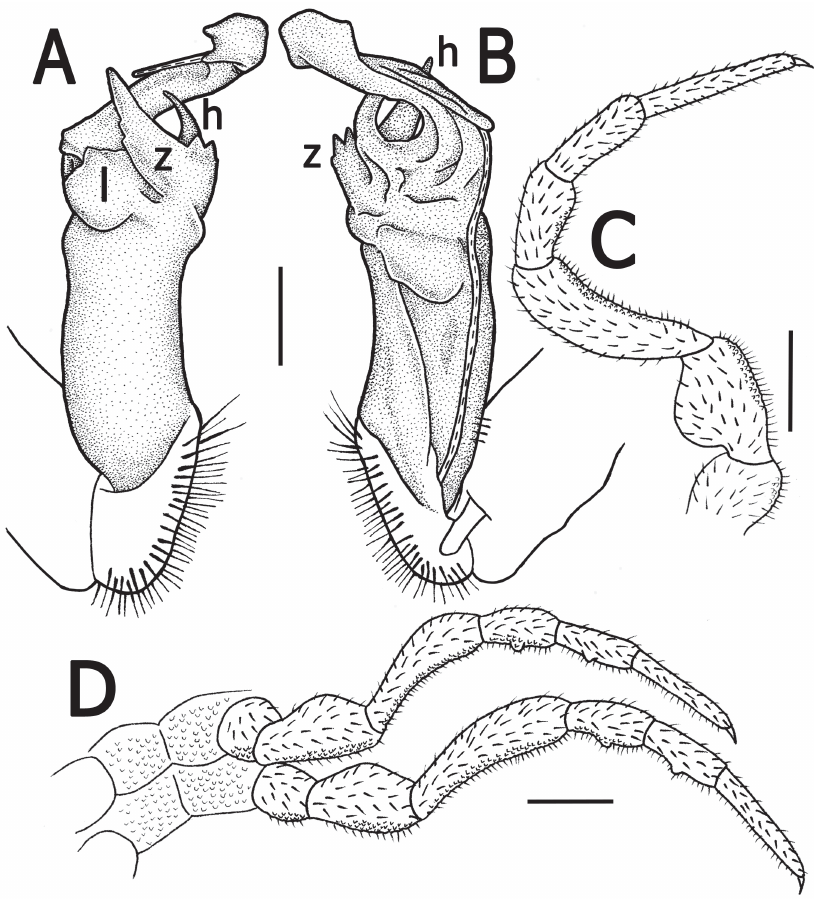
Fig. 24. Tylopus baenzigeri Golovatch & Enghoff, 1993, ♂. A–B . right gonopod, lateral and mesal views, respectively. C . Leg 8. D . Legs of segment 11. Scale bars = 0.5 mm. abbreviations are explained in the